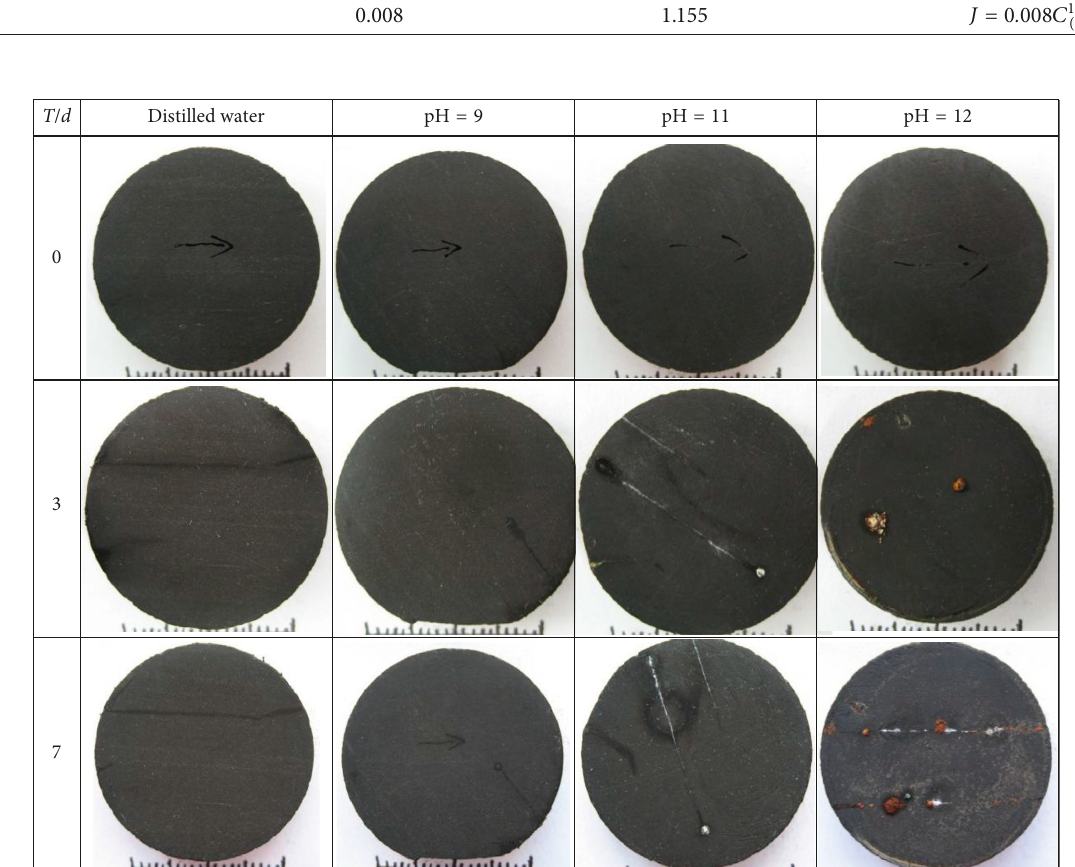
Figure 6: The results of shale fracture development rolling into different pH solutions at different